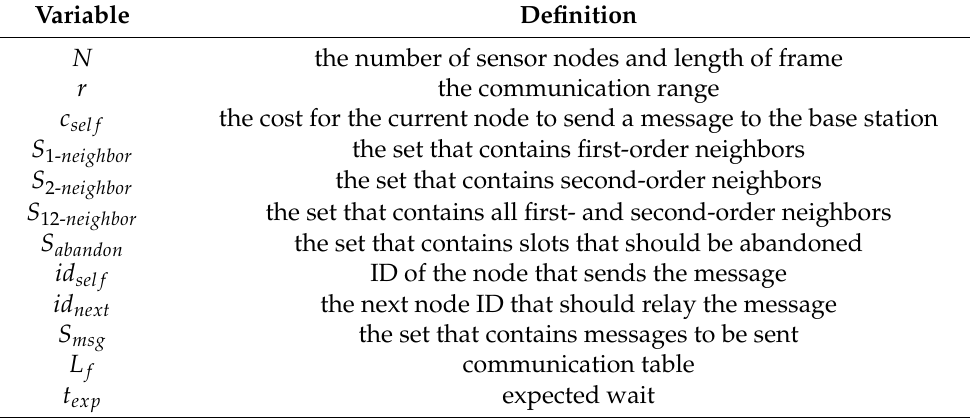
Table 1. Variable